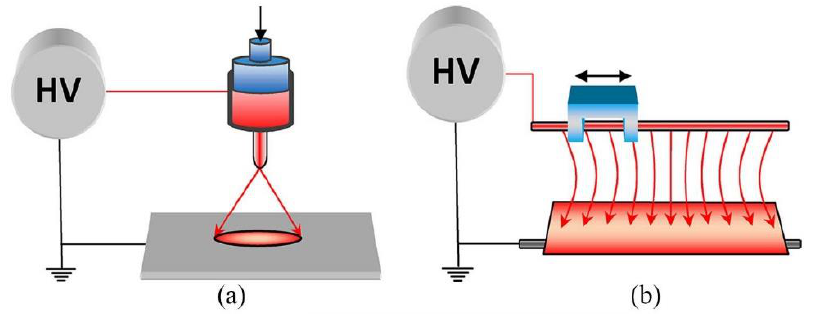
Figure 1. Electrospinning setup for ( a ) needle-based and ( b ) needle-free electrospinning methods. Adapted from reference [18], originally published under a CC-BY 4.0 license.